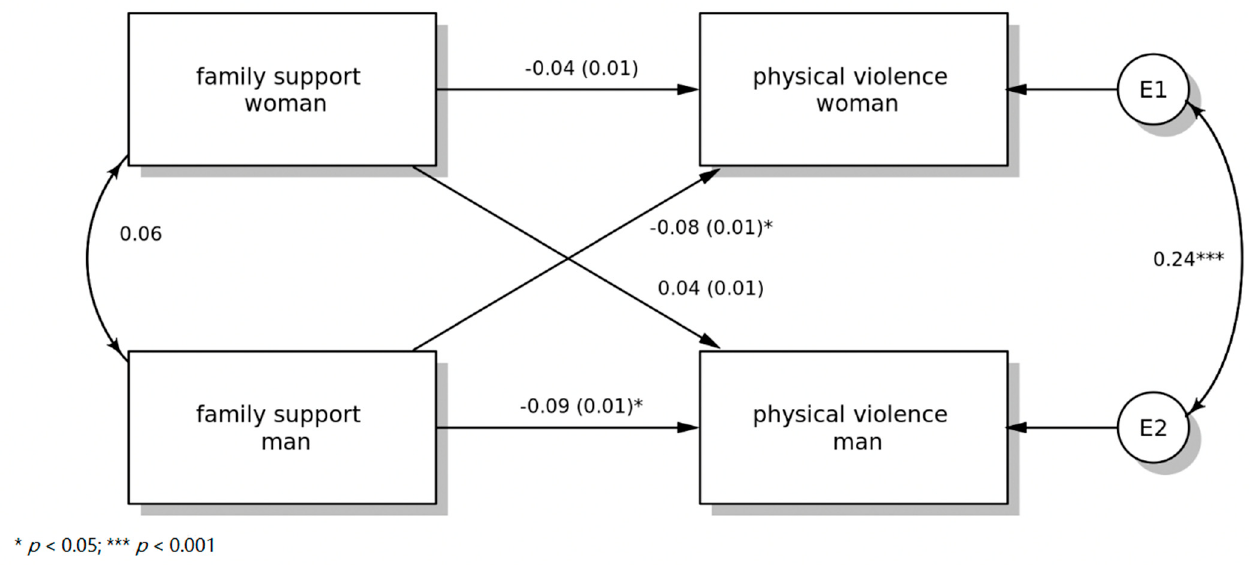
Figure 1. Model with standardized parameter estimates.